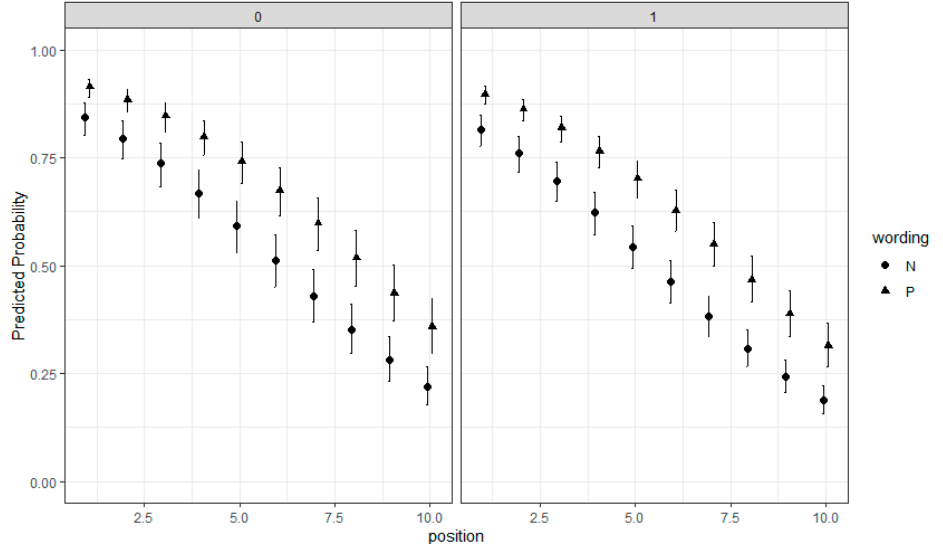
Figure 9. Estimate the latent regression LLTM and print the model output ( Note . 1 = Female and 0 = Male. ▲ = Positively-worded items and ⬤ = Negatively-worded items. Position refers to the positions of the items on the RSE scale. Error bars indicate the 95% confidence interval around the predicted probability values).